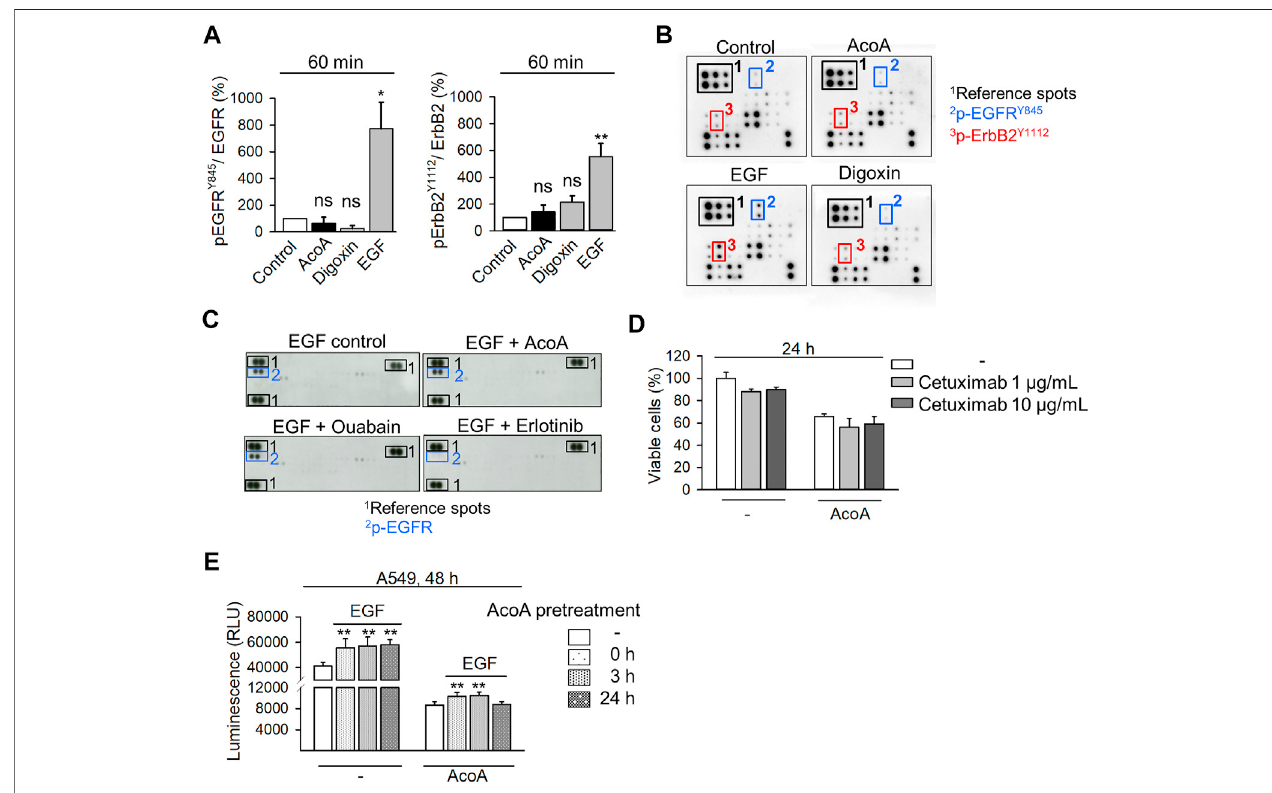
FIGURE 6 | AcoA does not signi fi cantly change EGFR phosphorylation and binding and activation by EGF. (A) Neither AcoA nor digoxin (both 100 nM) induce phosphorylation of EGFR family members in A549 cells. EGF (100 ng/ml) was used as a positive control. Phosphorylation of EGFR Tyr845 and ErbB2 Tyr1112 after 60 min treatment are quanti fi ed. Analysis was performed by protein array. (B) Representative membranes are shown in (C) Neither AcoA nor digoxin (both at 100 nM) affect EGFR phosphorylationinducedbyEGF(100 ng/ml)asanalyzed byatyrosine kinaseprotein array.A549cellswerepretreated for30 min withAcoA,ouabain (both 100 nM),orerlotinib(10 µM)andstimulatedwithEGF(100 ng/ml)for60 min. (D) NosynergisticcytotoxicityofAcoAandtheEGFRinhibitorcetuximab.A549lungcancer cellsweretreatedwiththeEGFRinhibitor cetuximab.After1 h,AcoA(100 nM)wasaddedandafter24 hcellviabilitywasanalyzedbyXTT.Dataaremean ± SEM, N (cid:1) 3. (E) AcoA and digoxin do not interfere with EGF-induced cell proliferation. Cell proliferation was quanti fi ed based on luminescence in luciferase-expressing A549 cells pretreated with 100 nM of AcoA for either 0, 3, or 24 h and stimulated with 100 ng/ml EGF for additional 48 h ( N (cid:1) 3). Data are mean ± SEM of N (cid:1) 3 independent experiments, * p < 0.05, ** p <